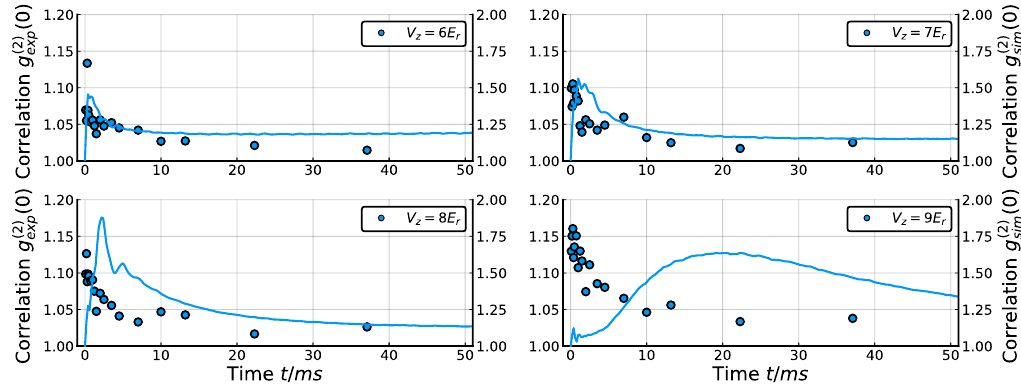
Figure 5: Correlation function g ( 2 ) ( 0 ) of the central atomic cloud for different lattice depths. Circles represent the experimental results and solid lines the